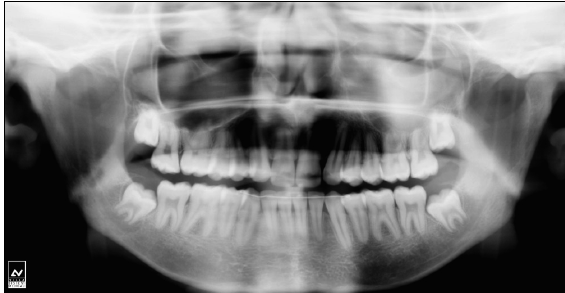
Figure 6b. 2 ½ years post-functional/1 year